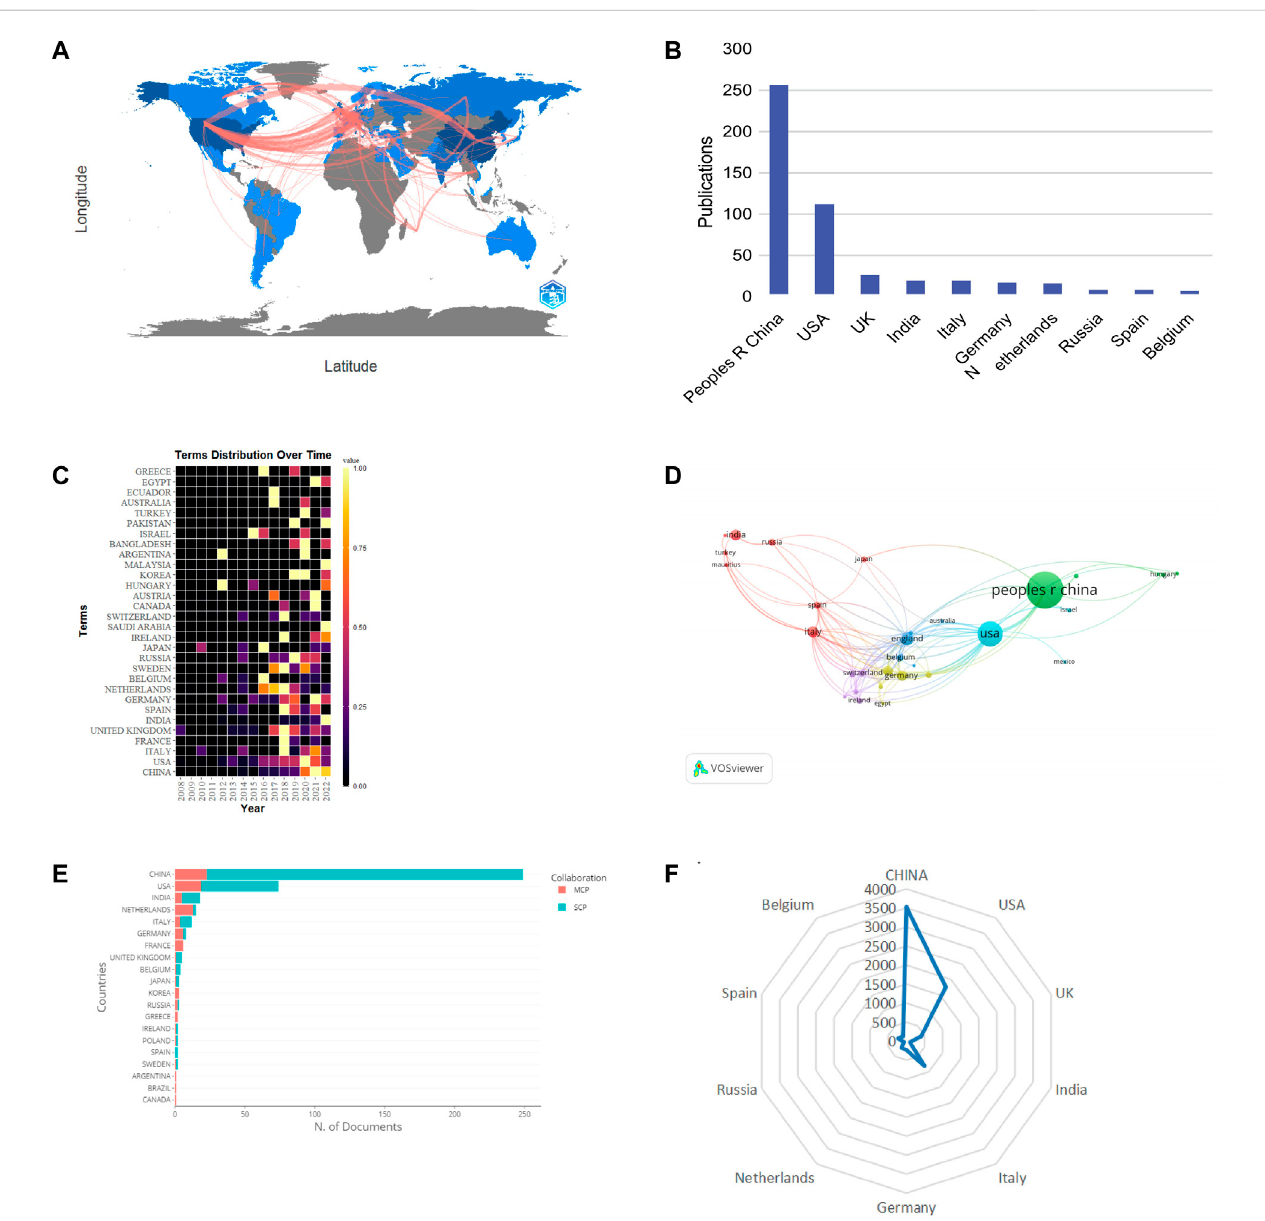
FIGURE 3 Analysis of countries/regions. (A) World map of the intensity of cooperation between countries. (B) Publications of the top 10 countries. (C) Distribution of the countries/regions ’ publications over time. (D) Cooperation network of countries. (E) Distribution of corresponding author ’ s country. MCP refers to the number of papers co-authored with different countries, and SCP refers to the number of papers co-authored with same countries. (F) Radar map of TGCS of the top 10 productive